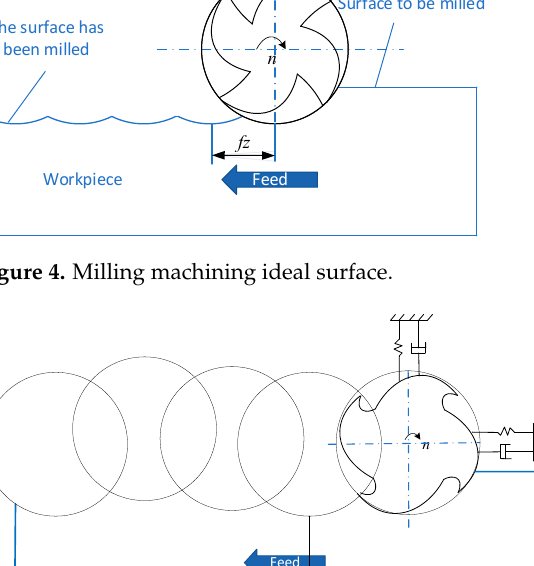
Figure 6. Milling process.